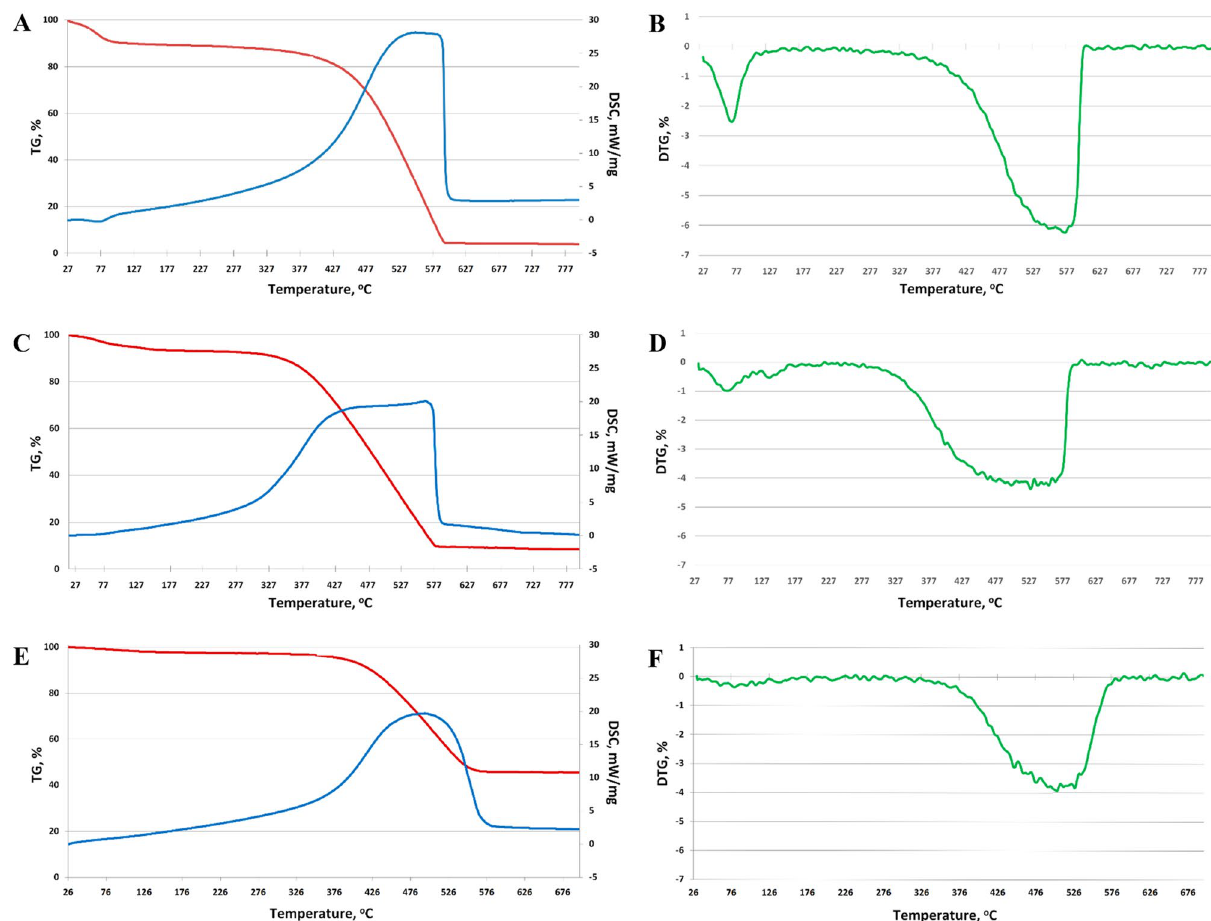
Figure 4. TGA (red line) and DSC (blue line) results from various biochar: ( A ) wood; ( C ) sunflower; and ( E ) rice husk; and DTG (green line) result from ( B ) wood; ( D ) sunflower husk; and ( F ) rice